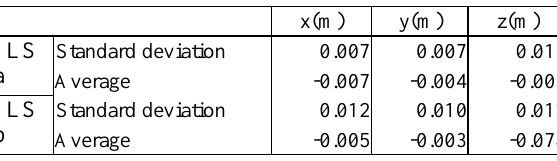
Table 2. Comparison MLS to TS target coordinates